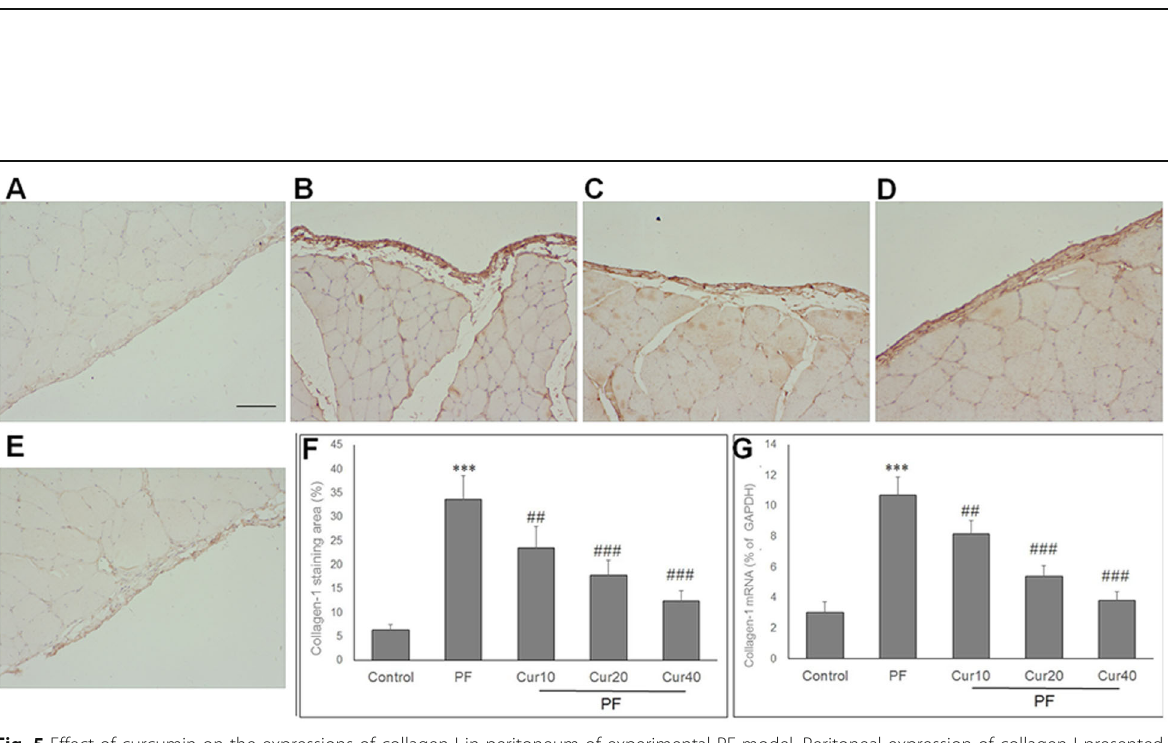
Fig. 4 Effect of curcumin on the expressions of α -SMA in peritoneum of experimental PF model. Peritoneal expression of α -SMA (myofibroblasts) was determined by immunohistochemistry, and presented as α -SMA staining area (%). a No α -SMA expression is found in the peritoneum of the control group. b After induction of PF, high α -SMA expression is detected. Curcumin showed markedly reduced expression of α -SMA at 10 mg/kg ( c ), 20 mg/kg ( d ) and 40 mg/kg ( e ) compared with the PF group. f The α -SMA expression in the peritoneum presented as α -SMA staining area (%) in each group. g qRT PCR showed the mRNA expression in the peritoneum of each group. ANOVA was performed and followed with Tukey ’ s post hoc test. *** P < 0.001 vs. control group; ## P < 0.01, ### P < 0.001 vs. PF